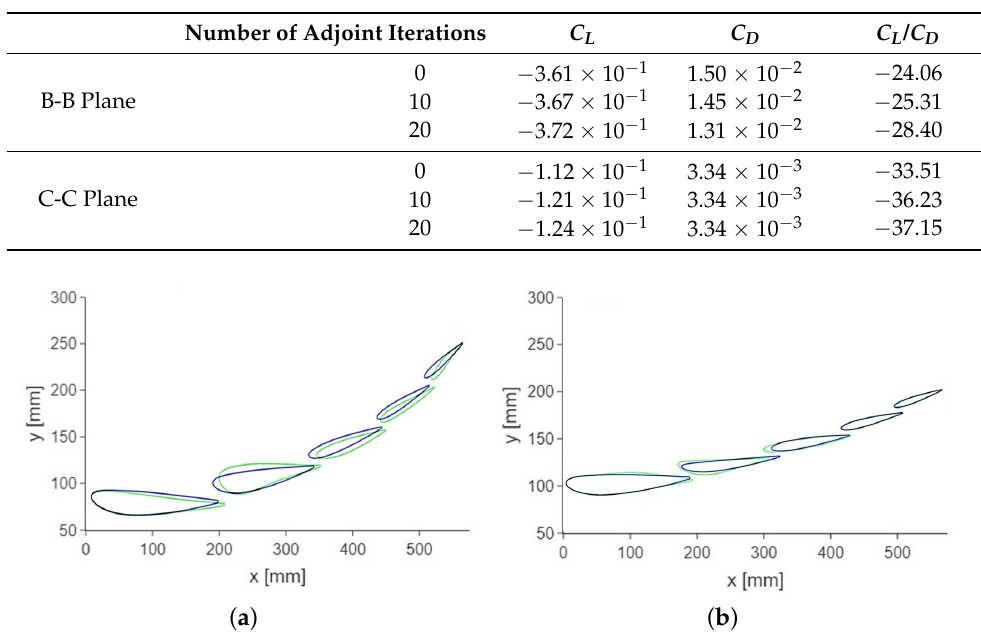
Table 4. Adjoint optimisation results up to 20 iterations.